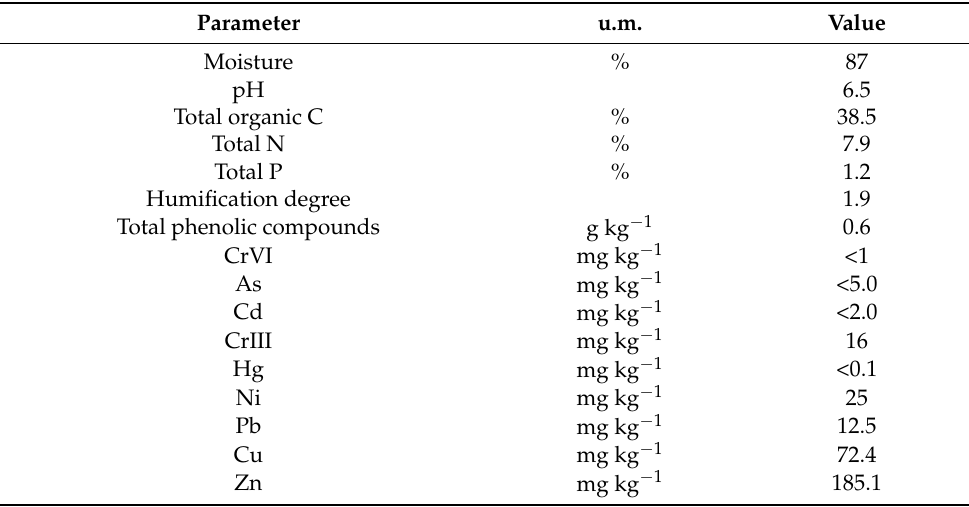
Table 1. Selected properties of BS (DM basis) applied to barley, common wheat, durum wheat, and oat in 2015 and